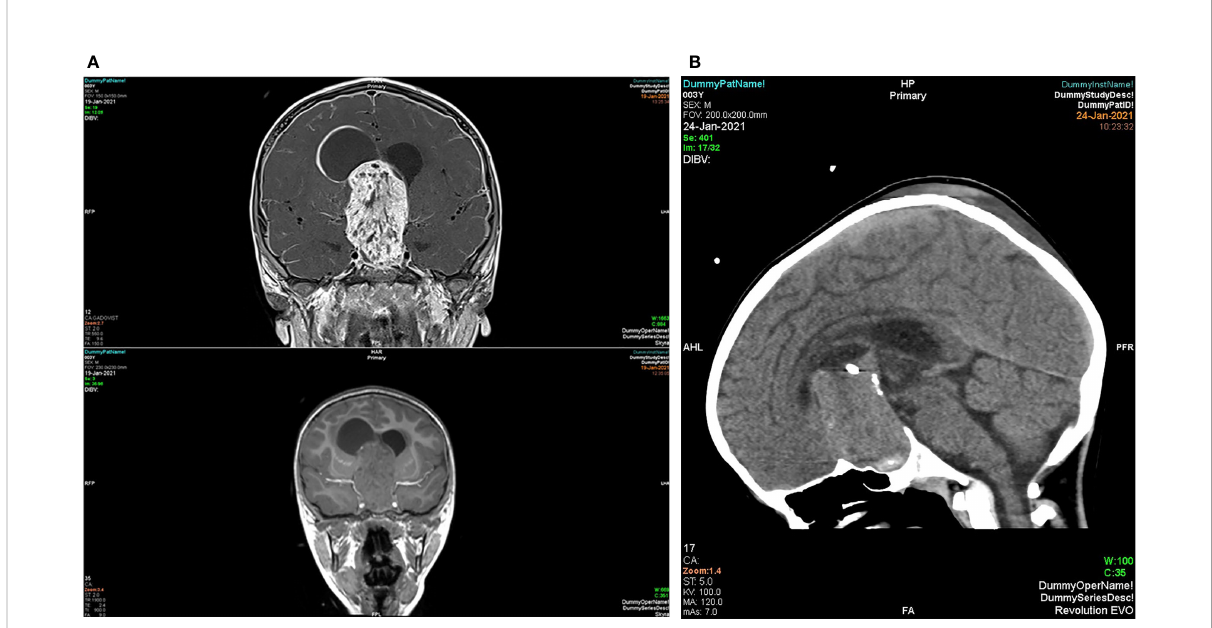
FIGURE 5 (A) MRI T1 with (top) and without (bottom) contrast coronal view of a giant craniopharyngioma with sellar and suprasellar solid enhancing parts; A large cystic component extends into the frontal horn of the right lateral ventricle. (B) A mid sagittal plane CT head of the same patient with evidence of sellar widening and peripheral calci fi